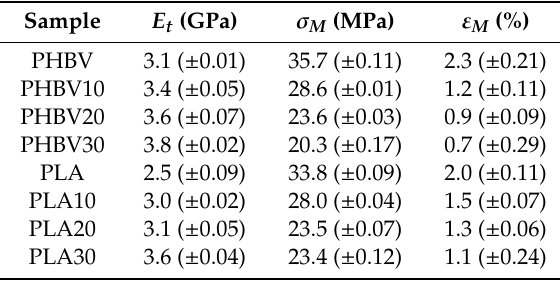
Table 1. Tensile properties of PHBV, PLA and their biocomposites and standard deviation values.